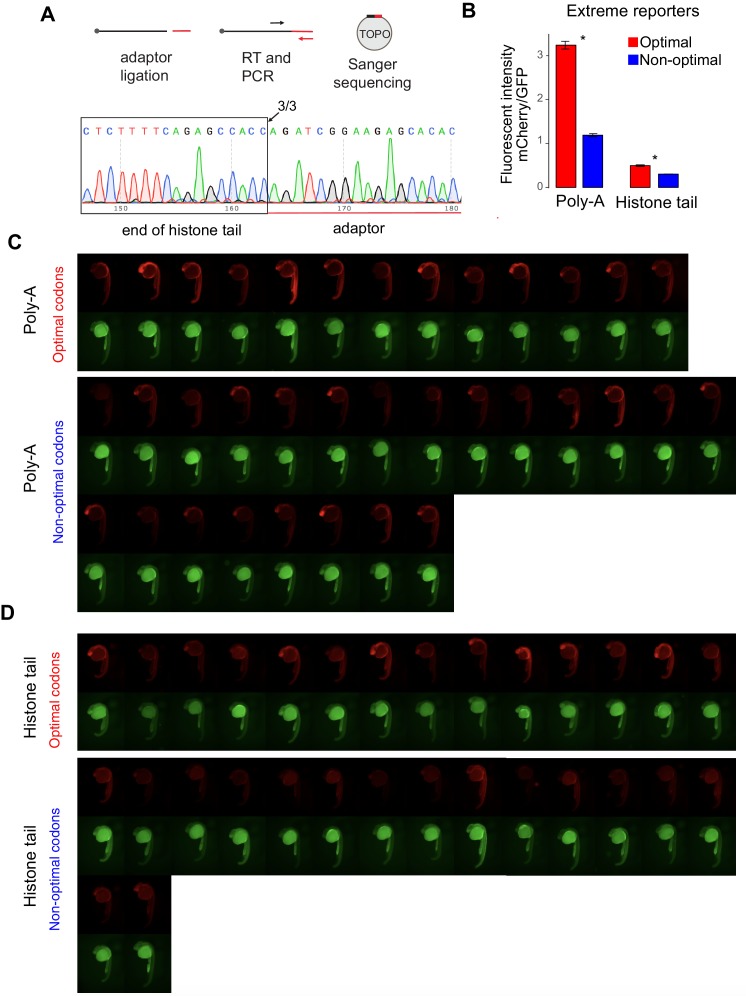
Poly(A)-tail is not required for the codon optimality mechanism in human and zebrafish.(A) Diagram and sequencing result of the 3’RACE assay to detect end of histone tail mRNA. Total RNA was ligated with adaptor for qPCR at the 3’end. PCR product was inserted into TOPO vector for sanger sequencing. 3/3 colonies from the histone tail, showed sharp, precise end, indicating no poly(A)-tails. (B) The extreme reporter enriched in optimal codons displayed higher fluorescent intensity than the one enriched in non-optimal codons, independent of the poly(A)- or histone-tail used. unpaired t.test is used. *p<0.01 (C) Fluorescence microscopy images of embryos at 24 hr post injection with the indicated 1nt-out of frame reporter of poly(A)-tail and GFP. (D) Fluorescence microscopy images of embryos at 24 hr post injection with the indicated 1nt-out of frame reporter of histone-tail and GFP.